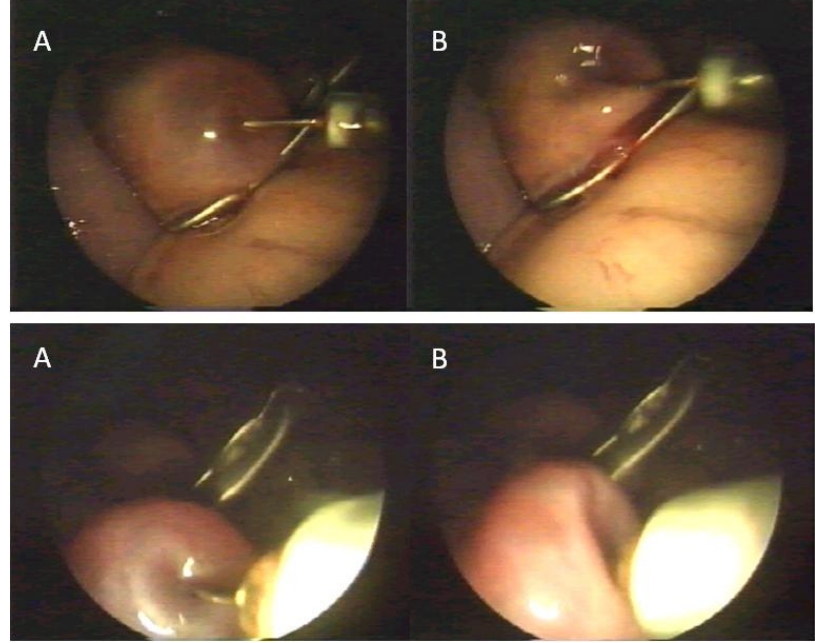
Figure 2. Oocyte recovery—aspiration of fluid from ovarian follicles with oocytes. ( A )—follicle before aspiration, ( B )—follicle after aspiration.